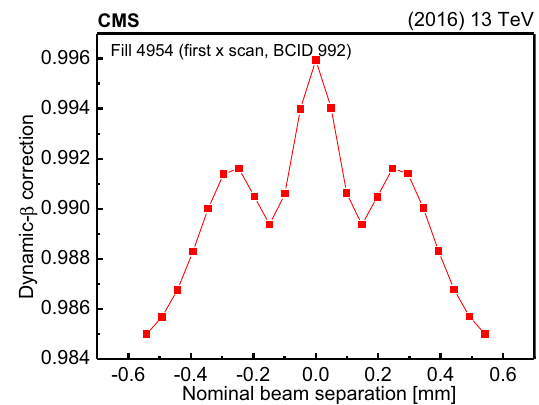
Fig. 9 Calculatedbeam-beam deflection due to closed-orbit shift (left) and the multiplicative rate correction for PLT due to the dynamic- β effect (right) as a function of the nominal beam separation for the beam